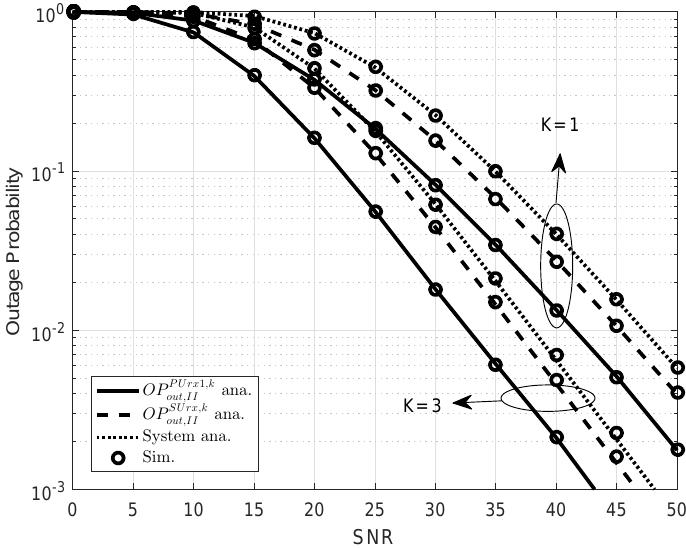
Figure 9. Scheme 2: Impact of K on outage comparison of PUrx 1 and SUrx versus SNR.